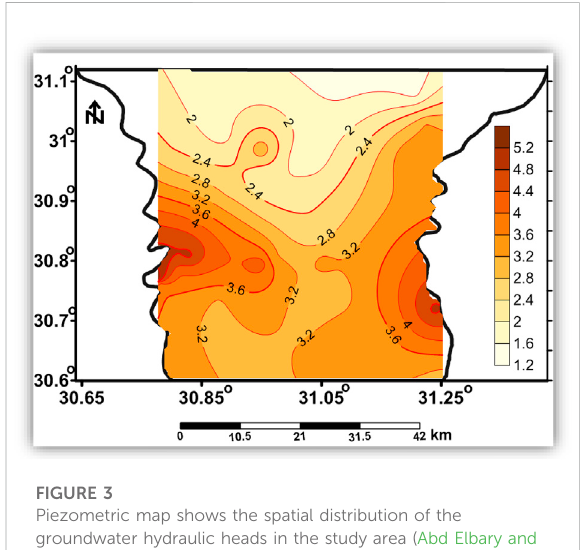
FIGURE 3 Piezometric map shows the spatial distribution of the groundwater hydraulic heads in the study area (Abd Elbary and Thesis, 2011).